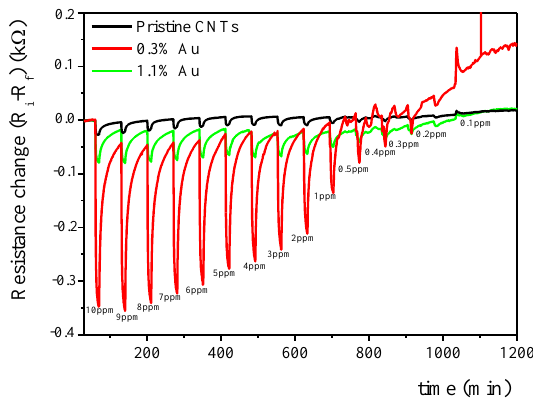
Figure 5. Time response of the NO 2 gas chemiresistor based on pristine CNTs films, and functionalized with Au-loading of 0.3%at. and 1.1%at., at a working temperature of 150 °C.